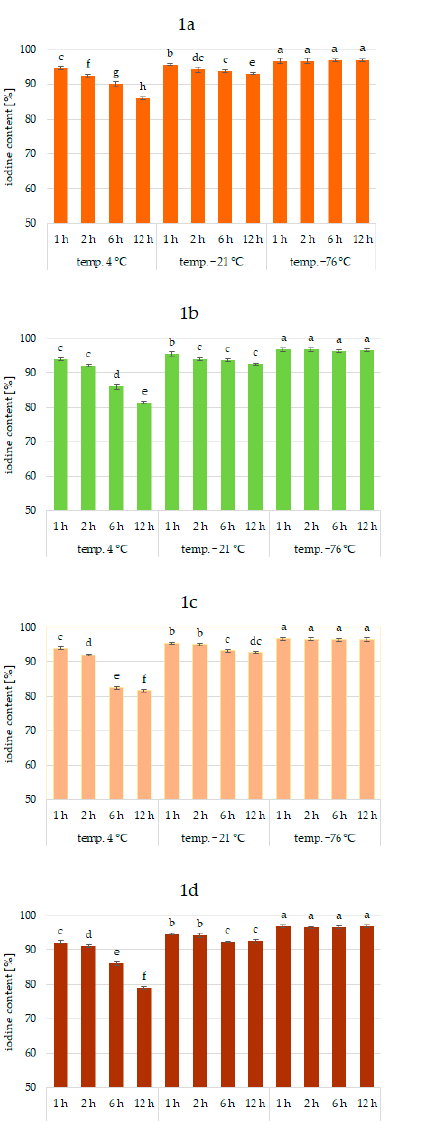
Table 1. Statistical significance of predictors of covariance models for changes in iodine content in selected iodine carriers during impregnation.